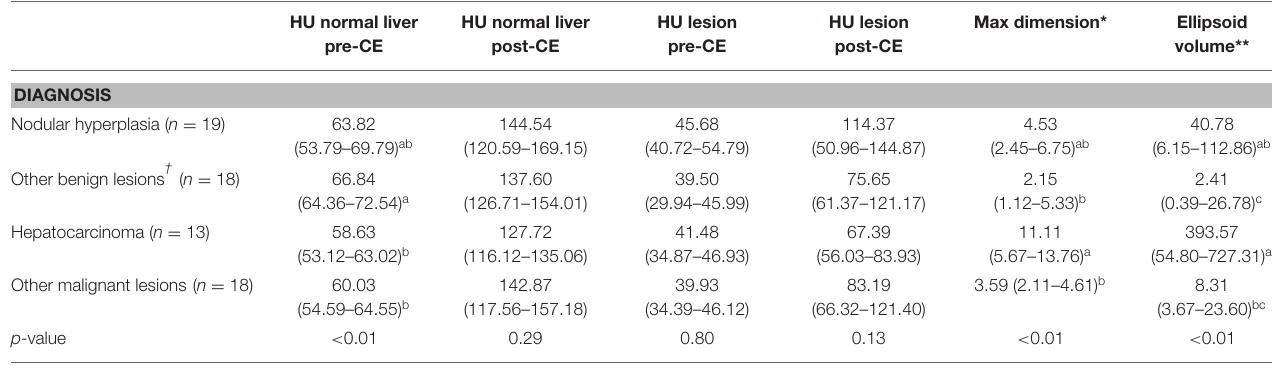
TABLE 2 | Quantitative features of the lesions, classified based on cytological or histological examination, are reported as medians along with the first and third quartile values and the p -value. HU normal liver